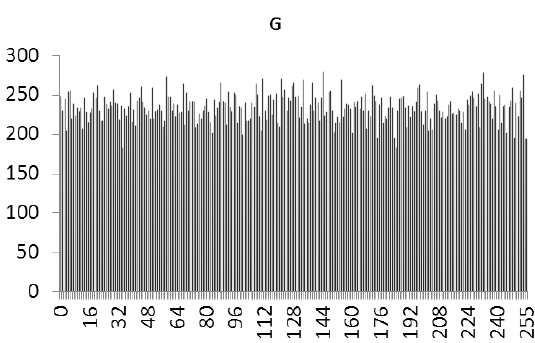
Figure 21. Statistical chart of G value distribution after encryption.